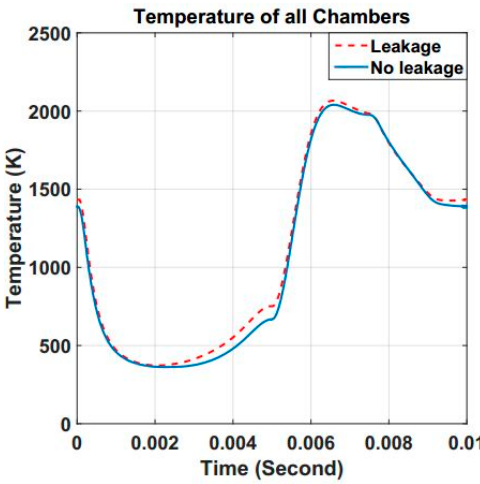
Figure 14. Temperature of working fluid vs. time over one cycle (100 Hz).